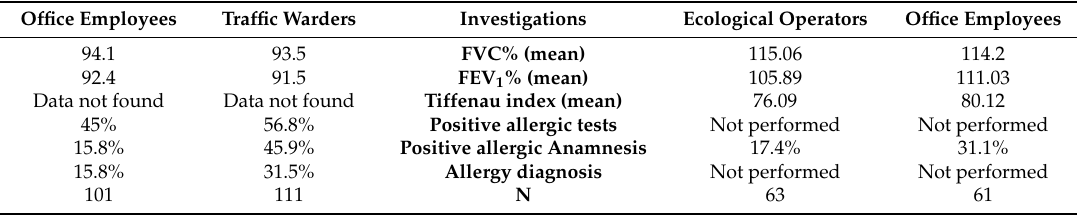
Table 2. Data concerning exposed workers’ characteristics, results of allergic and spirometric tests and results of dedicated